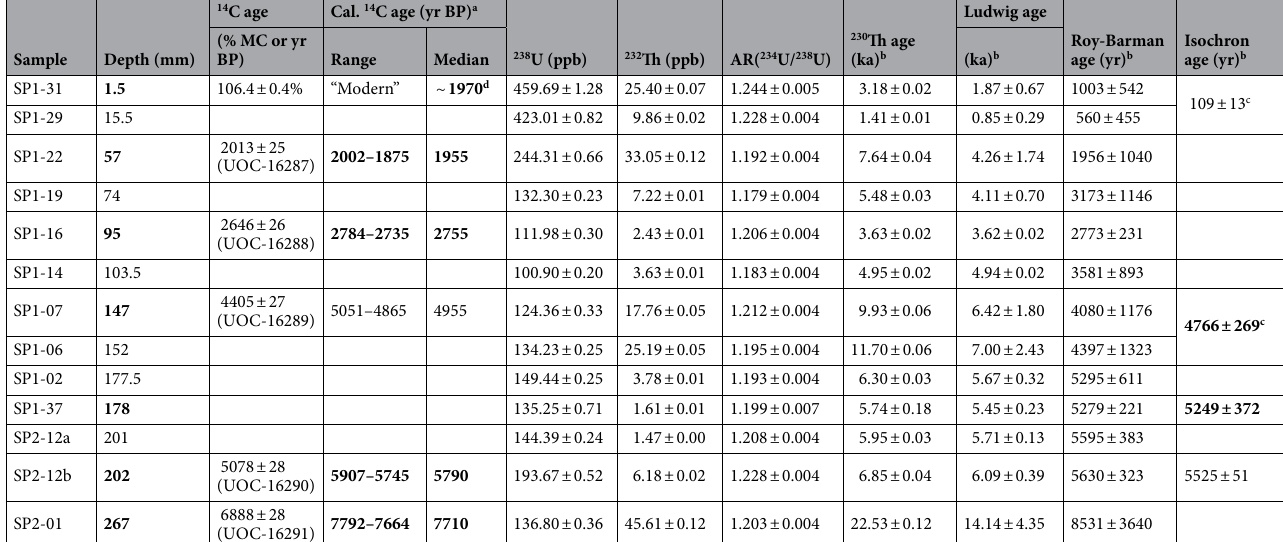
Table 1. Radioisotopic data ( 14 C and U–Th) of the Soprador do Carvalho stalagmite. a 95.4%